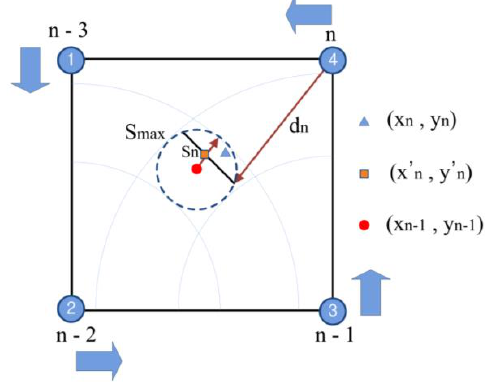
Figure 4. Searching and tracking method in RTL system.